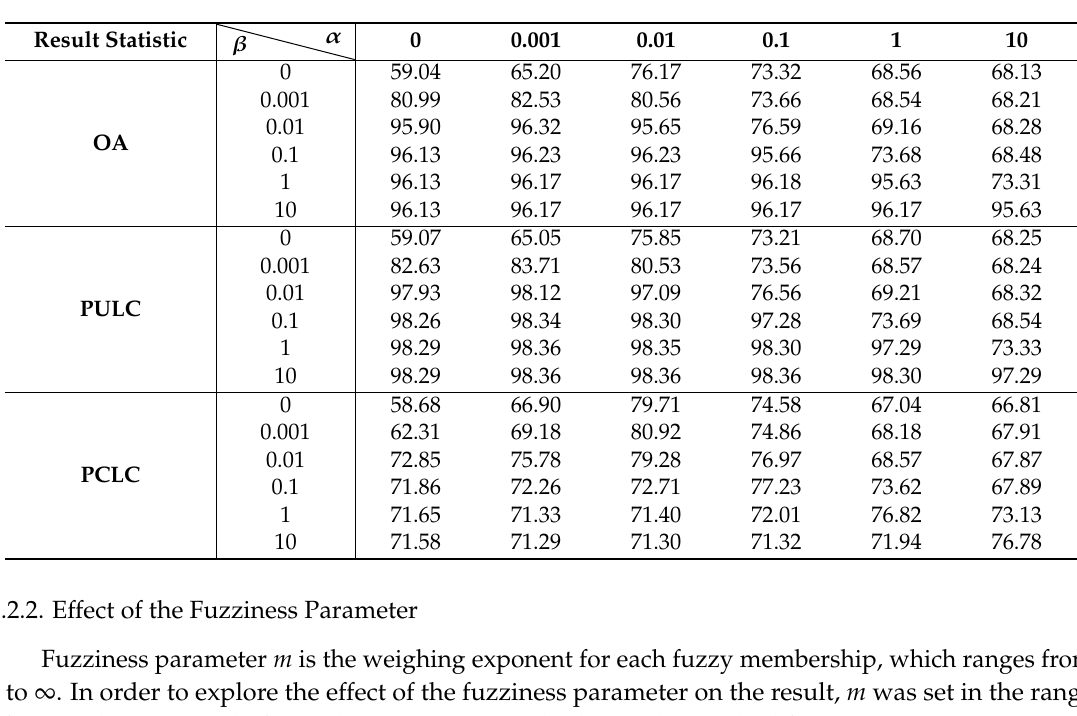
Table 4. Accuracy statistics of the FCM_STSRM method with different weighting coefficients (%).